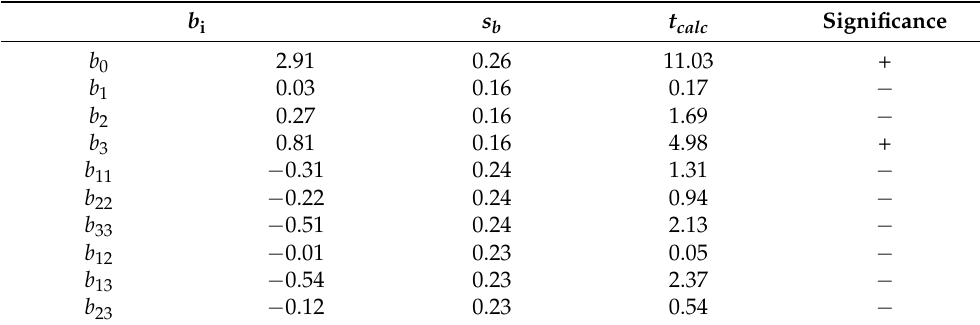
Table 8. The coefficients of polynomials found for mechanical properties of the PHUs.